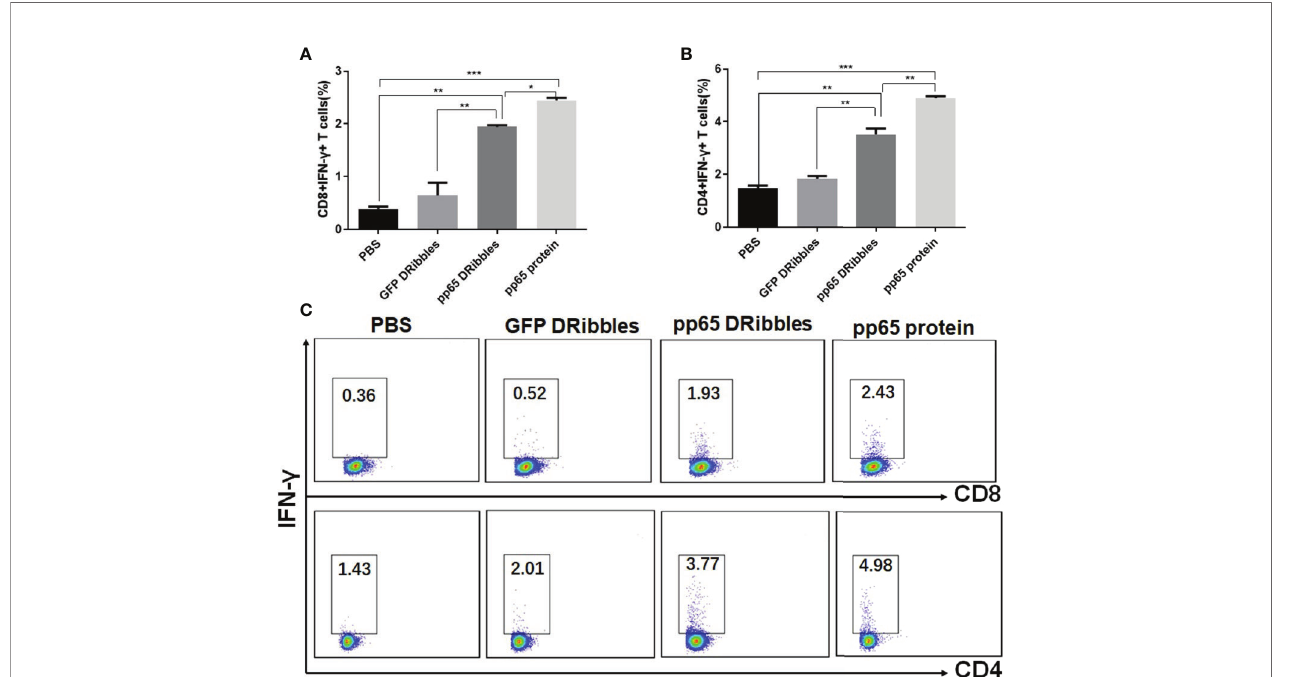
FIGURE 5 | Human B cells could effectively present DRibbles antigens to activate human memory CD8 + and CD4 + T cells. Puri fi ed human B cells from PBMC of CMV positive donors were loaded with CMVpp65 + DRibbles, control GFP + DRibbles or pp65 protein. After 12 h, autologous puri fi ed human CD8 + T or CD4 + T cells were added. Intracellular cytokine staining (ICS) was employed to calculate the percentage of CD8 + IFN- g + T cells (A) and CD4 + IFN- g + T cells (B) . (C) The representative dot plot from one of the CMV positive donors was shown. Data are representative of three independent experiments with similar results from three